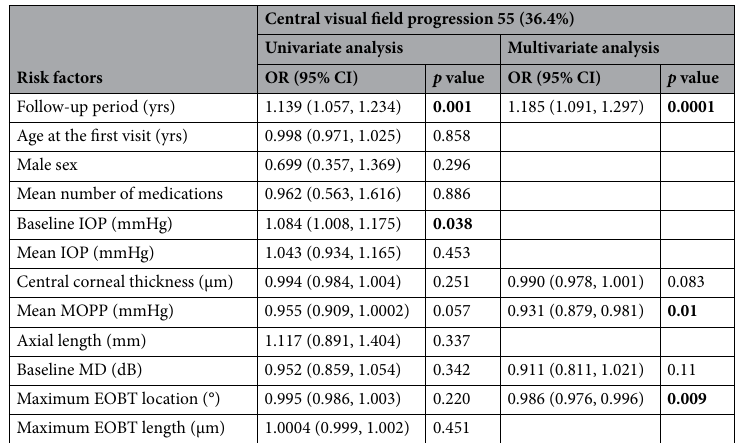
Table 6. Risk factors associated with visual field progression in the central visual field. CI confidence interval, EOBT externally oblique border tissue, IOP intraocular pressure, MD mean deviation, MOPP mean ocular perfusion pressure. The best multiple logistic regression model was chosen based on the Akaike Information Criterion. Factors with statistical significance are marked in